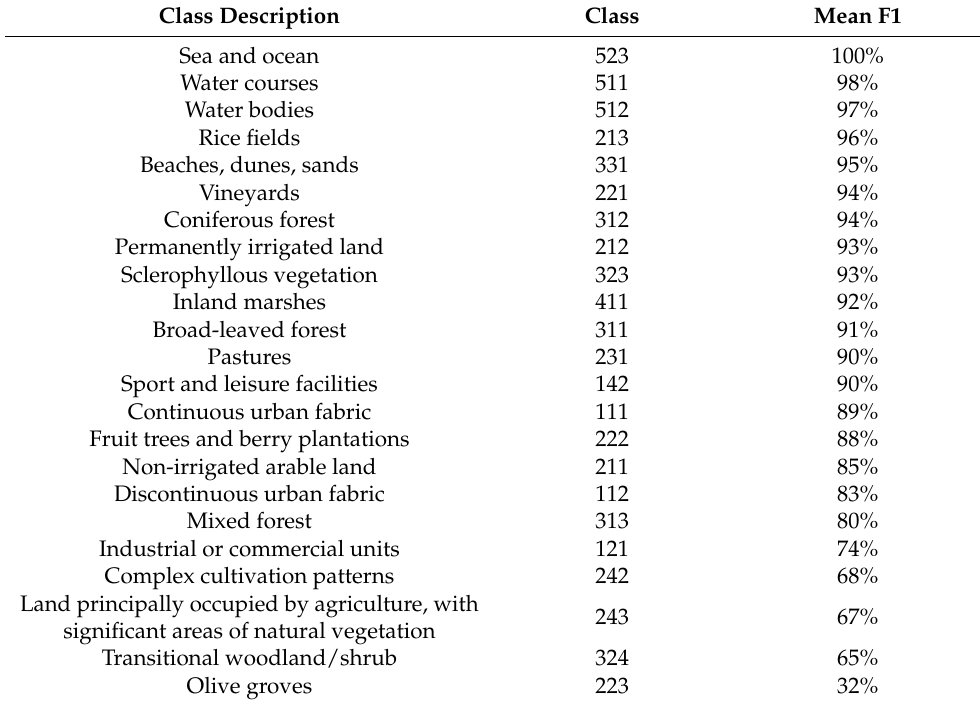
Table 10. Mean F1-scores of Sentinel-2 image classifications of the best algorithms for each region.